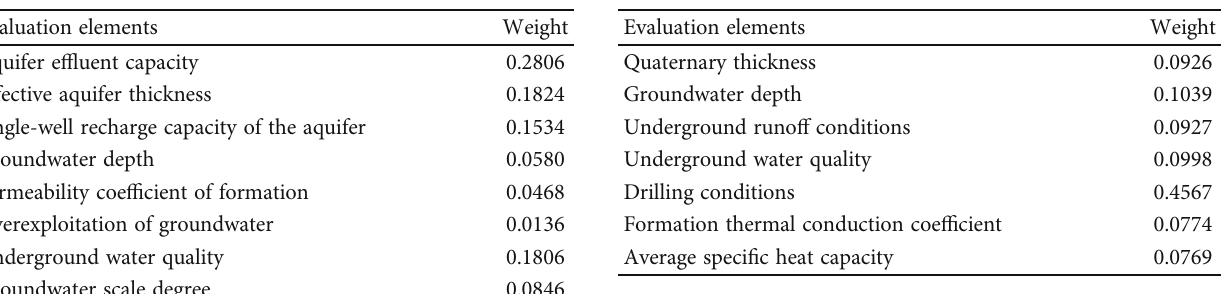
Table 3: Weight table of the suitability of the ground source heat pump.